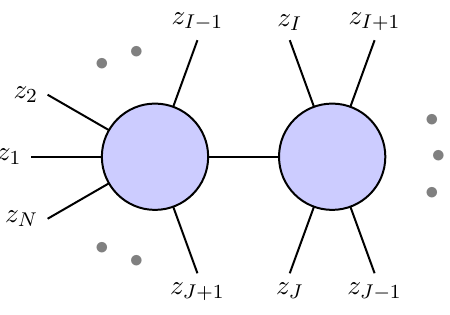
Figure 1 . Internal line of a Feynman